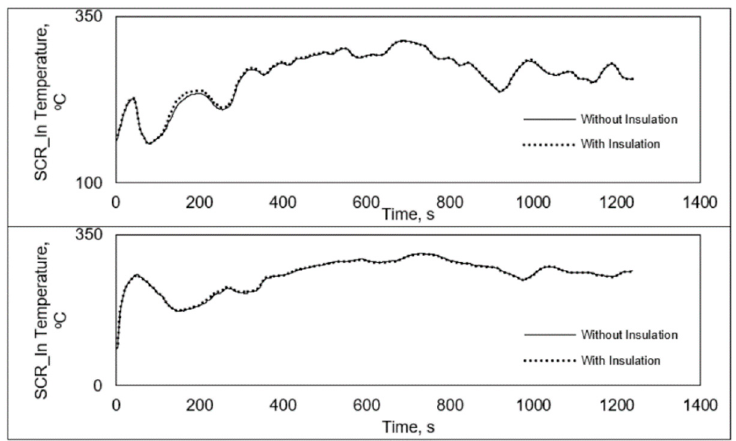
Figure 9. Exhaust gas temperature results with insulation and without insulation.